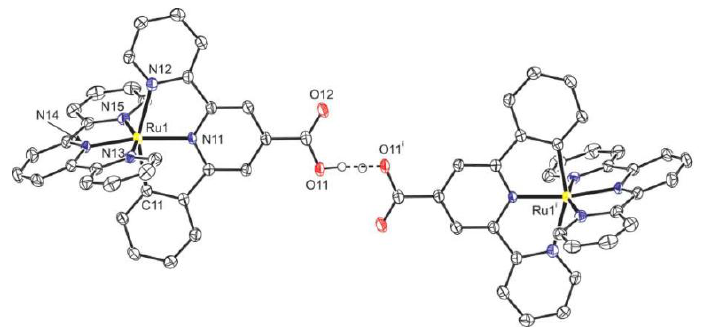
Figure 28. Crystal structure of complex 37 in form of its dimer [132] (Adapted from Ref 131 with permission of The Royal Society of Chemistry).